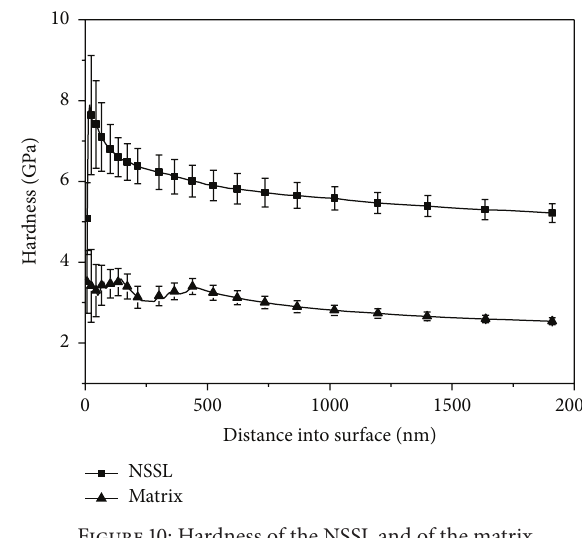
Figure 10: Hardness of the NSSL and of the matrix.